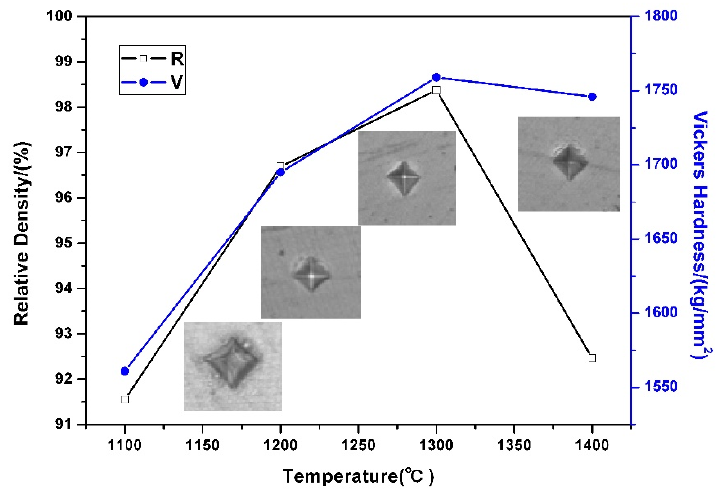
Figure 7. Relative density and Vickers hardness of ultrafine cemented carbides at different sintering temperatures for 40 min.